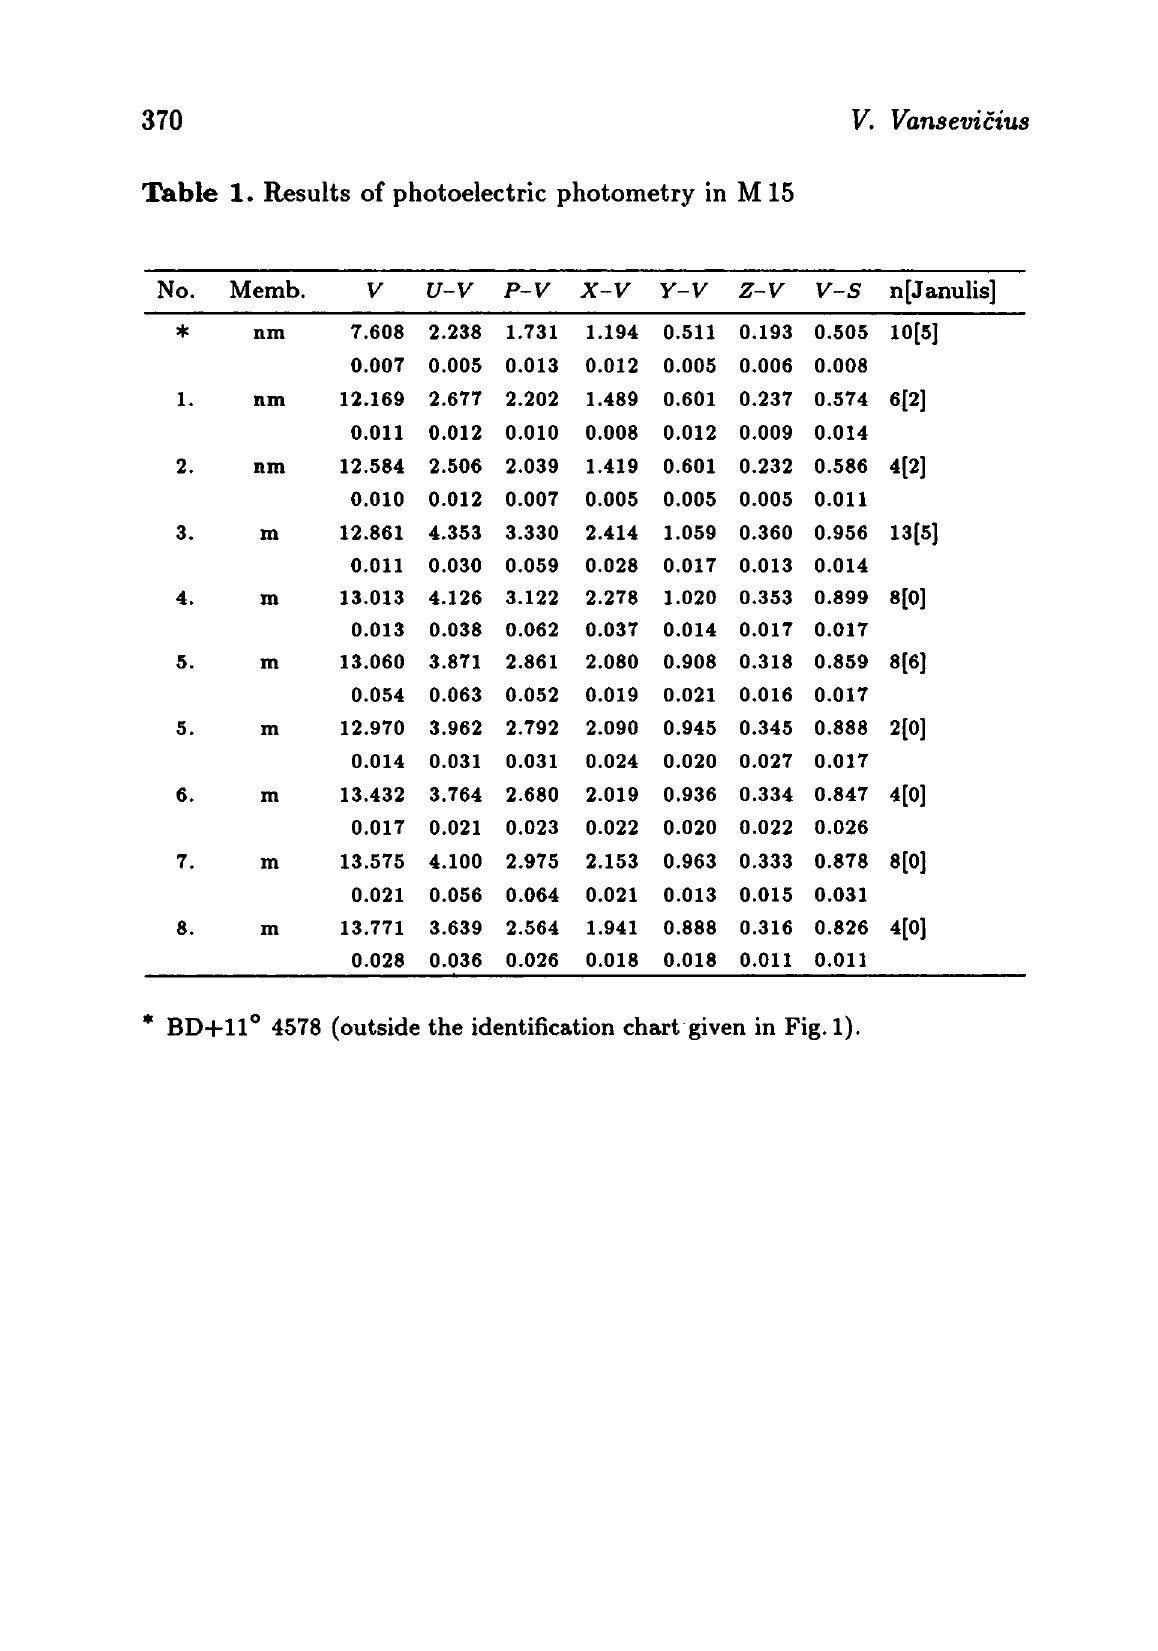
Table 1. Results of photoelectric photometry in M 15